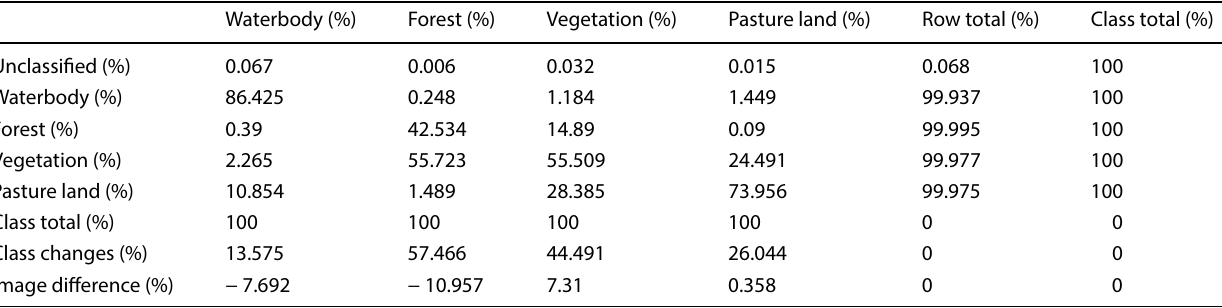
Table 8 Change detection statistics